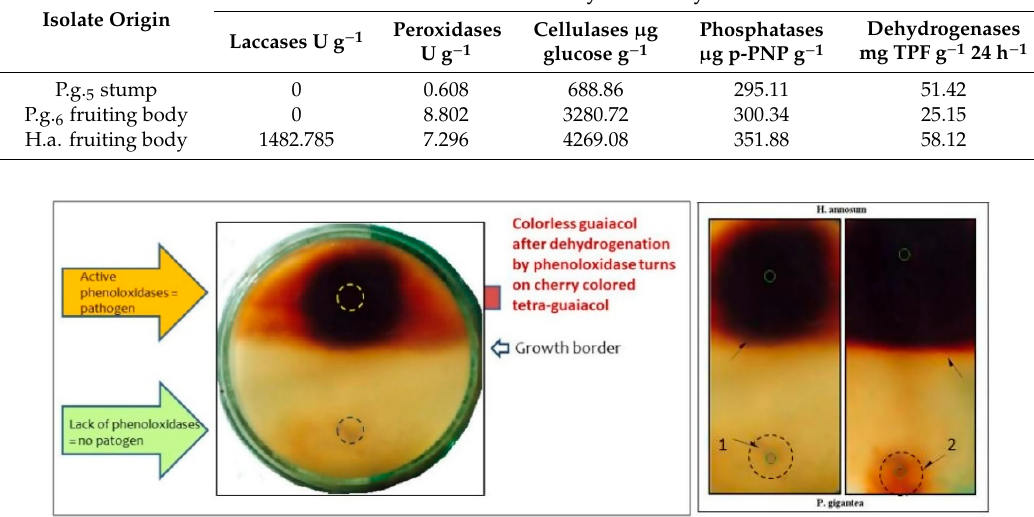
Figure 6. Color reaction of pathogen ( H. annosum ) and saprotroph ( P. gigantea ) enzymes in dual cultures on agar medium with quaiacol (left) and comparison of enzymatic activity of two P. gigantea isolates (right), 1 and 2— P. gigantea isolates, (Sierota [87]).